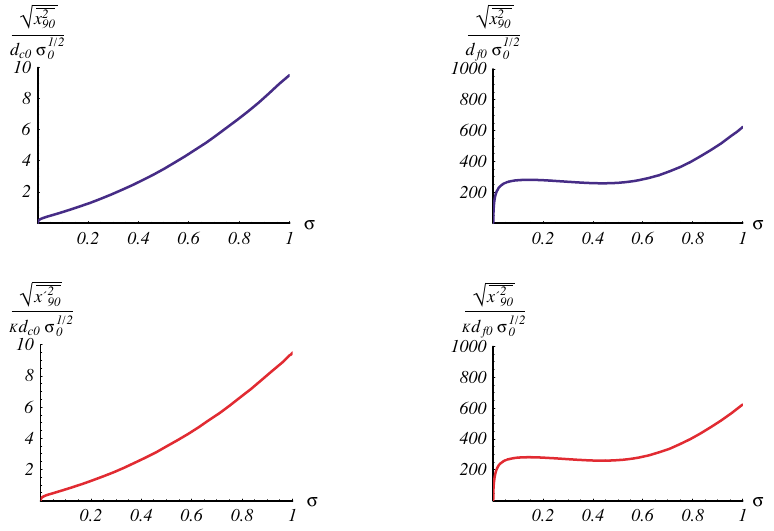
FIG. 3. (Color) Normalized rms lateral displacement (upper row, blue curves) and angular divergence (lower row, red curves) for the last bunch as a function of position in the accelerator due to misalignment of the cavities (left column) and focusing elements (right column). See Table I for the choice of parameters.